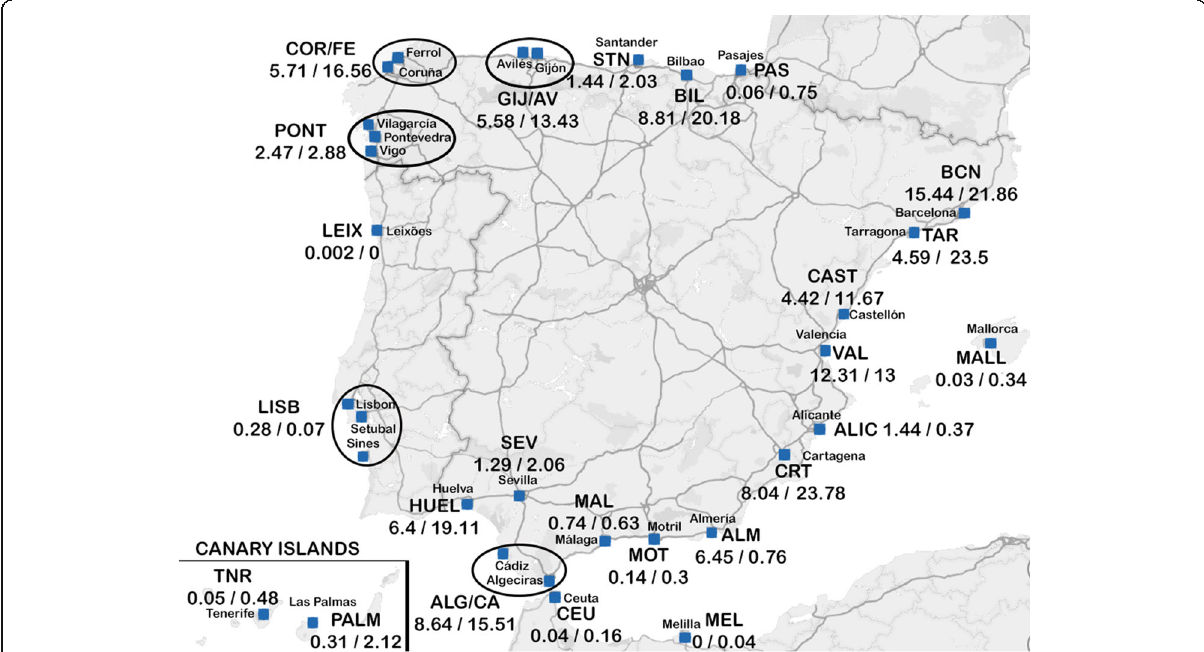
Fig. 1 Location of the ports studied, and global Exports / Imports in trillions of Tonnes. Ports grouped due to their closeness are represented within an